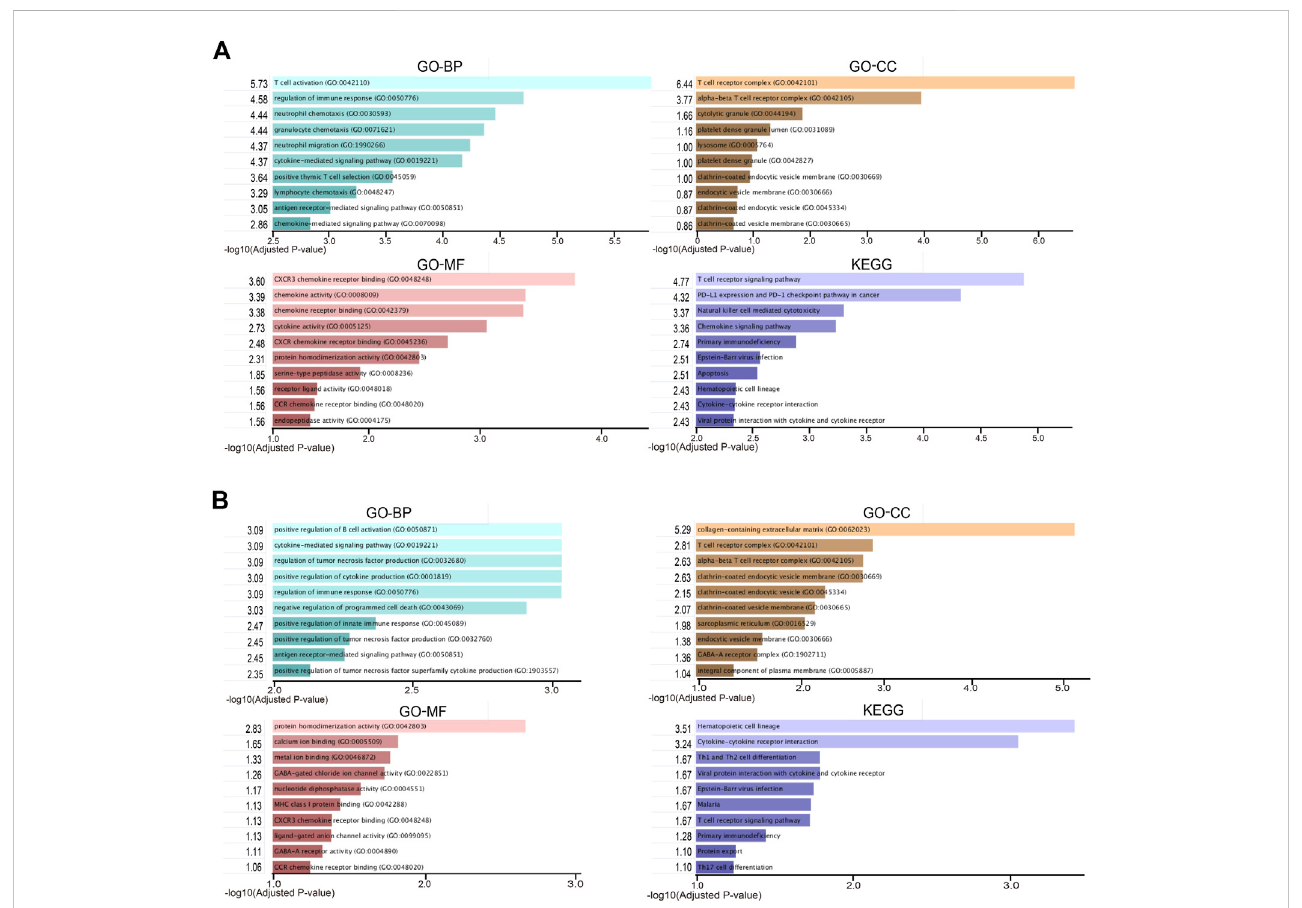
FIGURE 2 Representative enrichedfunctionaltermsofRAsamplescomparedwithOAsamples. (A) Mostsigni fi cantlyenrichedtermsofGO-BP,MF,CCcategories, andKEGGpathwaysinRA-LJsamples versus OAsamples (B) Signi fi cantlyenrichedtermsofGO-BP,MF,CCcategories,andKEGGpathwaysinRA-SJsamples compared with OA samples. The x -axis represents the value of [-log (Adjusted p